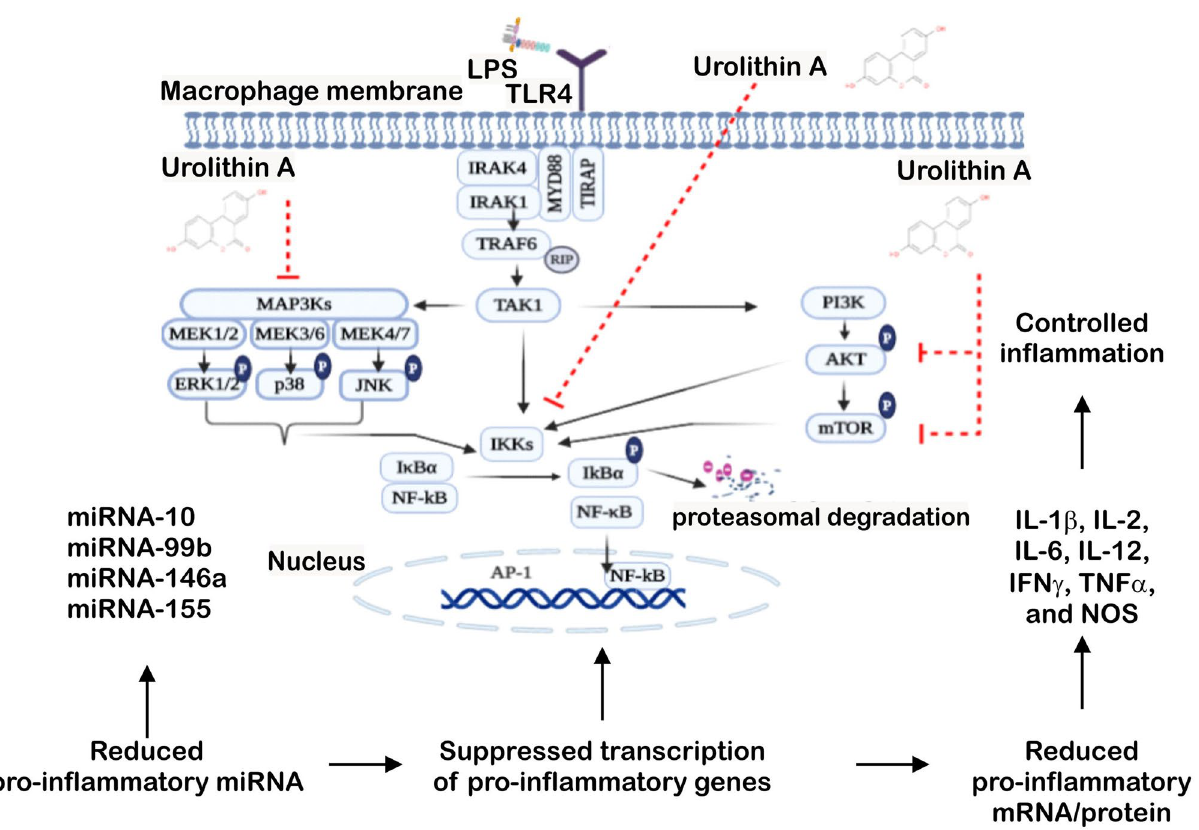
Figure 8. Urolithin A controlled NF-kB inflammatory response. LPS stimulates TLR4 signalling cascades. Urolithin A impairs the NF-kB activation through the inactivation of IKKs. Urolithin A suppresses MAPKs activation through blocking ERK, p38 and JNK phosphorylation. Additionally, urolithin A inhibits the phosphorylation of AKT and mTOR protein. Abbreviation: LPS; lipopolysaccharide; IR, ionizing radiation; TIRAP, TIR adaptor protein; MyD88, myeloid differentiation primary-response gene 88; IRAK, interleukin-1 receptor associated kinase; TRAF, TNF receptor associated factor; RIP, receptor-interacting protein kinases; TAK, transforming growth factor beta-activated kinase 1; IKK, IκB kinase; MAPK, mitogen activated protein kinase; PI3K, phosphatidylinositol 3-kinases; mTOR, mechanistic target of rapamycin; ERK, extracellular regulated kinase; JNK, c-Jun N-terminal kinase; NF-κB, nuclear factor-κB; IκB, kinase complex; AP, activator protein; IL, interleukin; IFN, interferon; TNF, tumor necrosis factor; and NOS, nitric